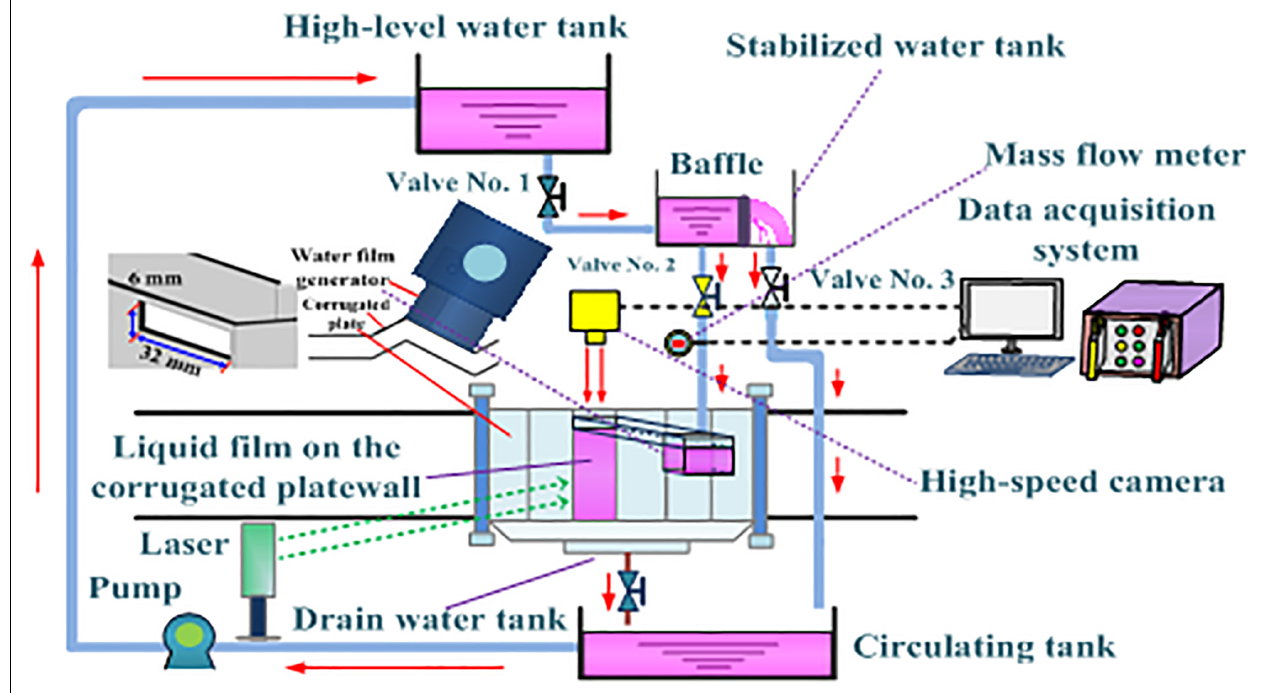
FIGURE 2 | Schematic diagram of the experimental